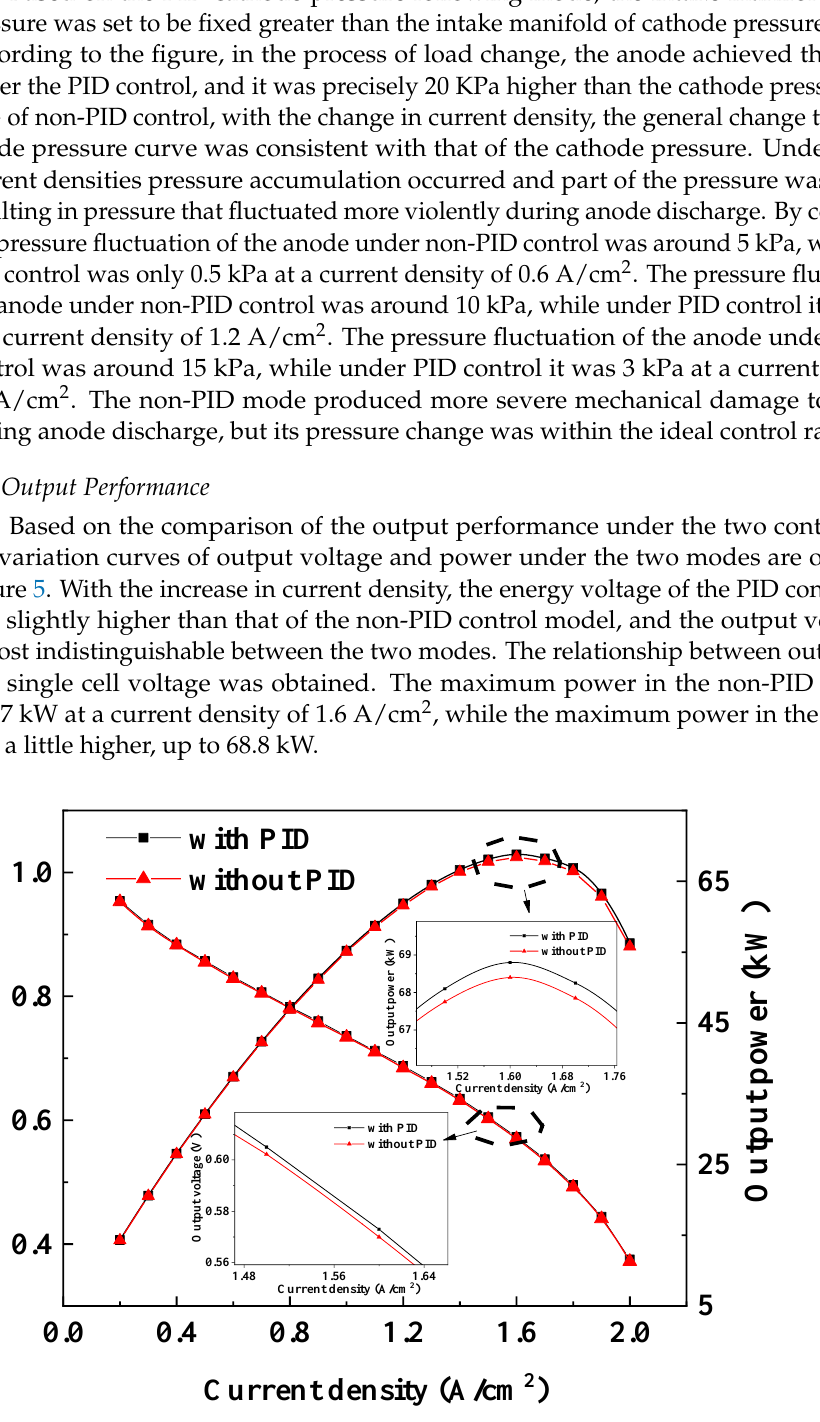
Figure 5. Output performance with different current densities under two modes.